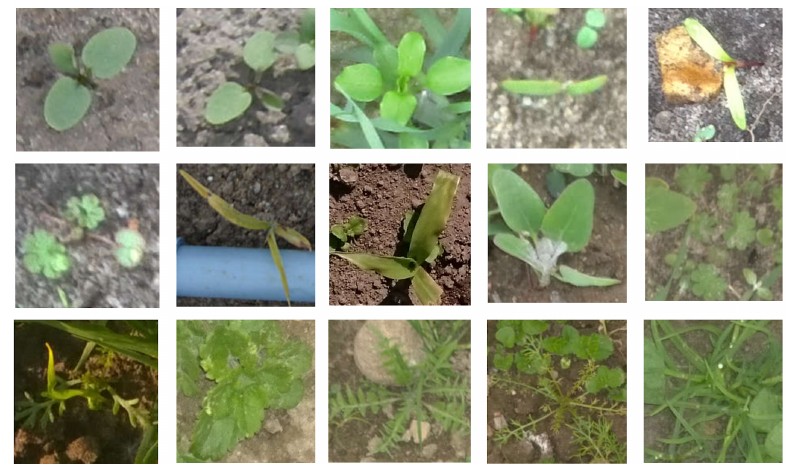
Figure 2. A random selection from the image datasets.